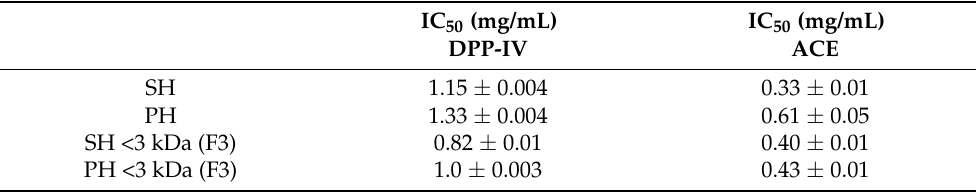
Table 3. IC 50 values obtained testing SH, PH and their corresponding low molecular fractions (<3 kDa) against DPP-IV and ACE